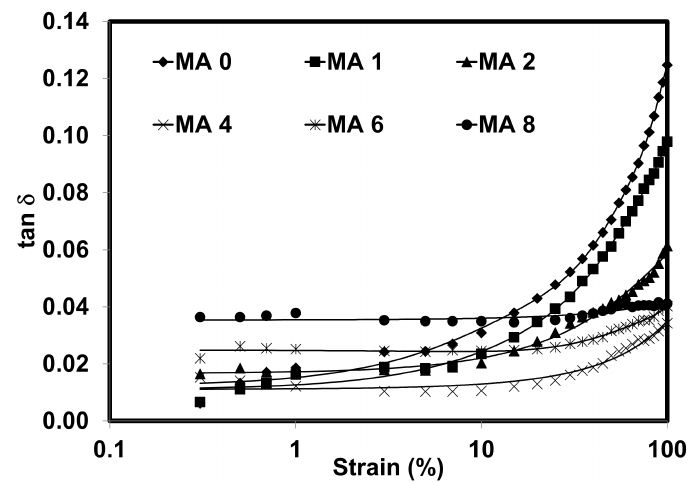
Figure 11. Damping characteristics (tan δ ) of NR / HNT and MNR / HNT composites.